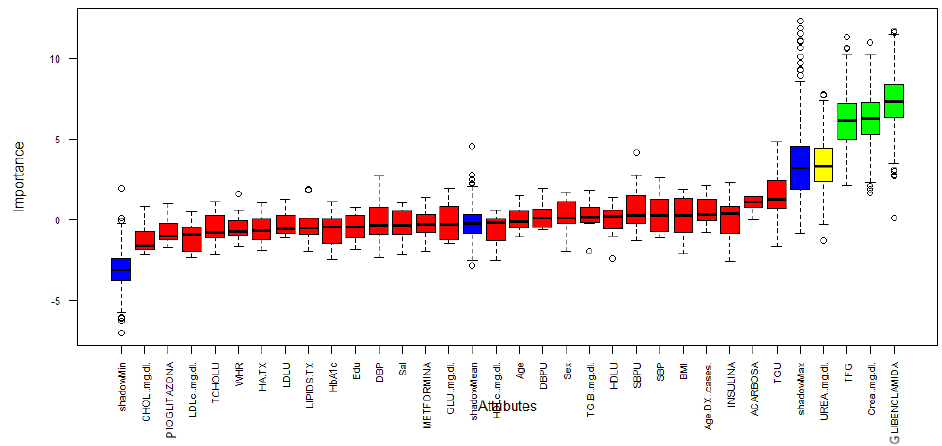
Figure 3. Variable Importance.